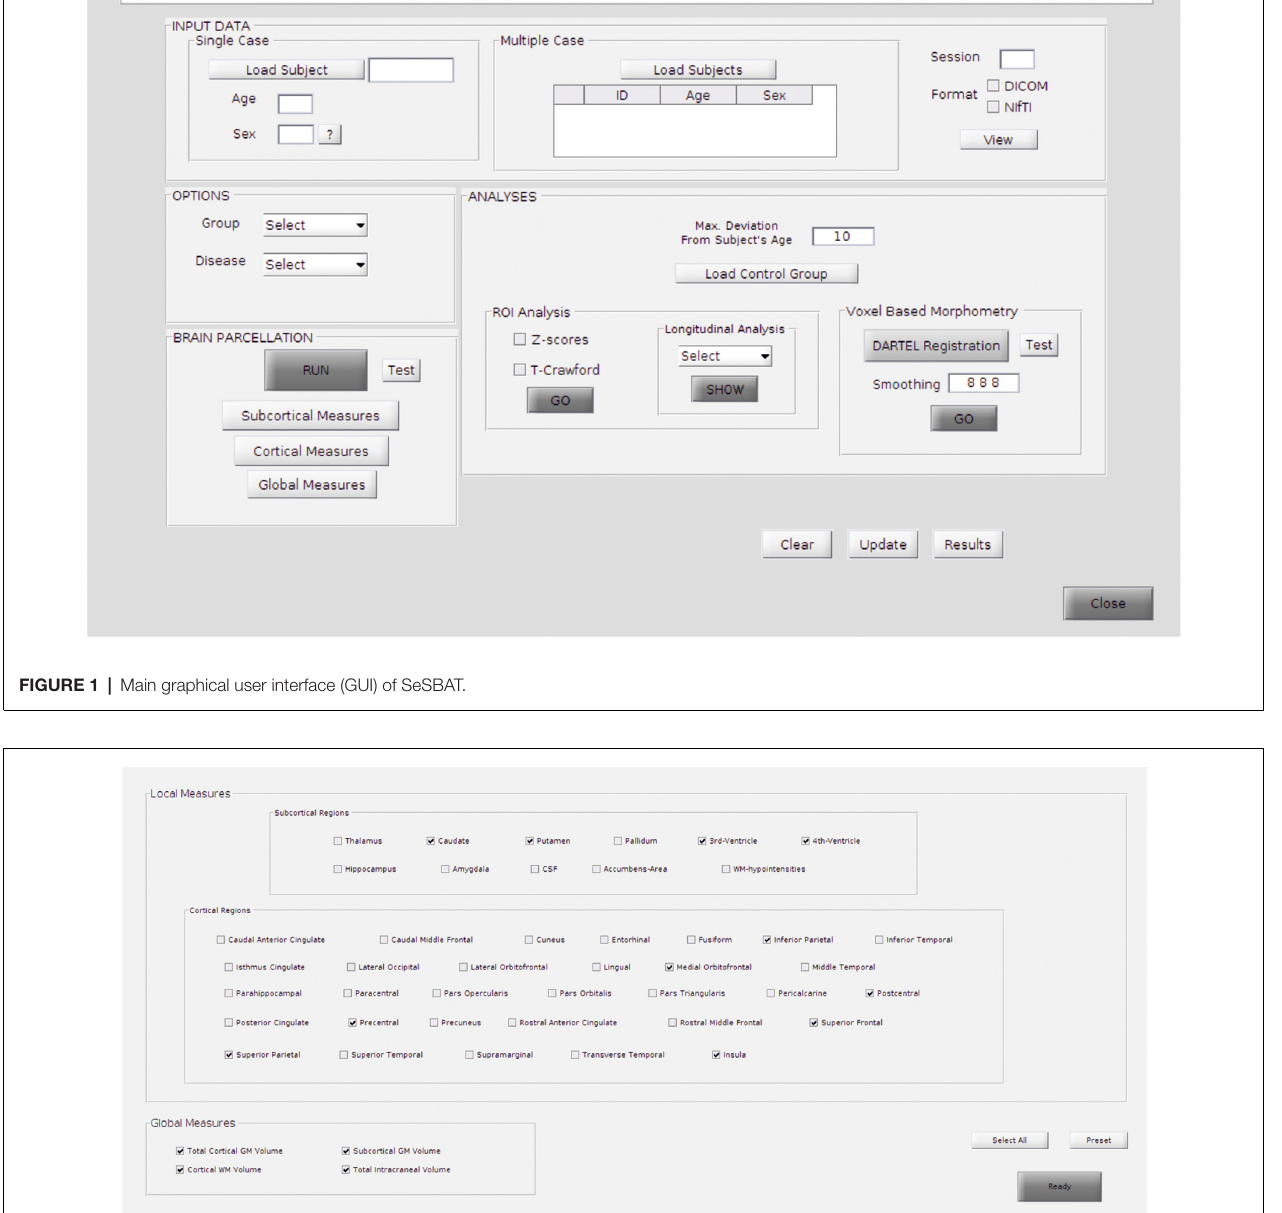
controls’ ages. In this way, the subject is only compared to those controls that are the closest in age. By default, the age deviation is set to 10 (age range of control group = Subject’s age ± 10), but this can be tuned by the user. Although this toolbox only considers age as a confounding factor, it would